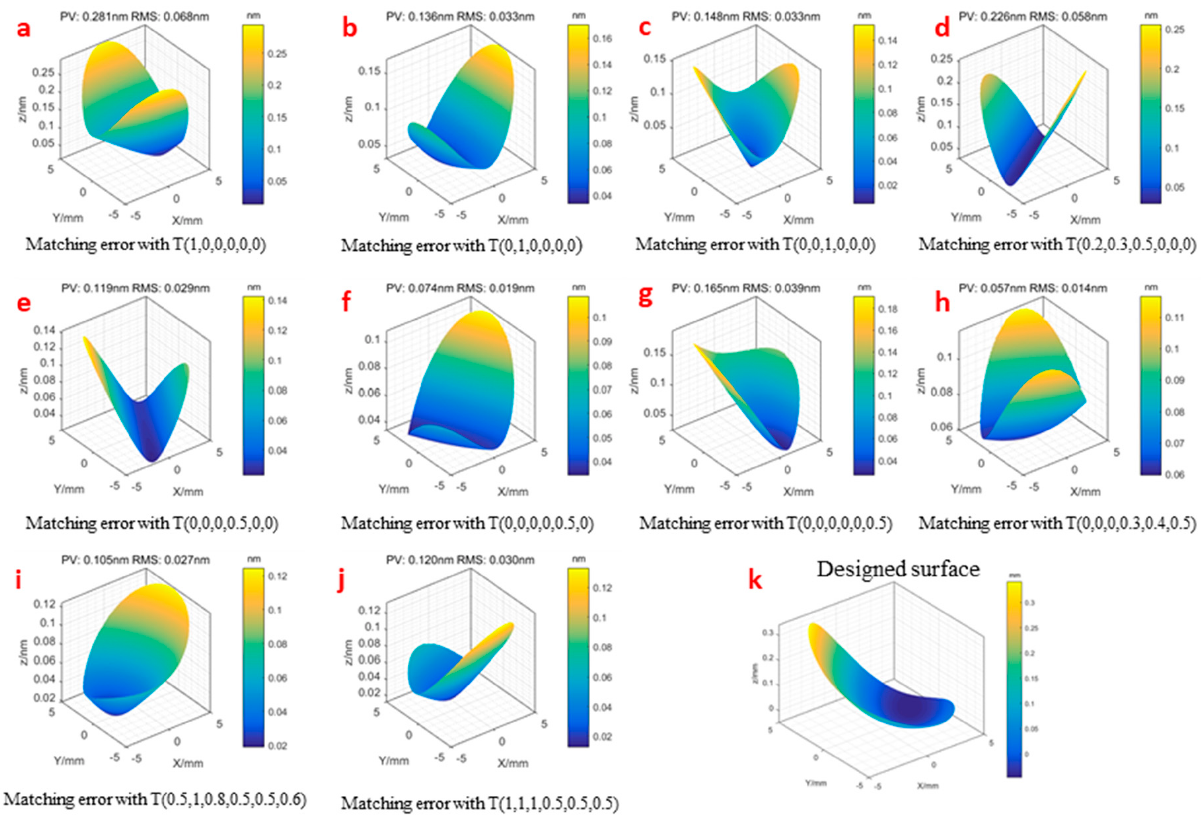
Figure 5. ( a – k ) Simulation results of matching error with different coordinate transformations and designed surface.